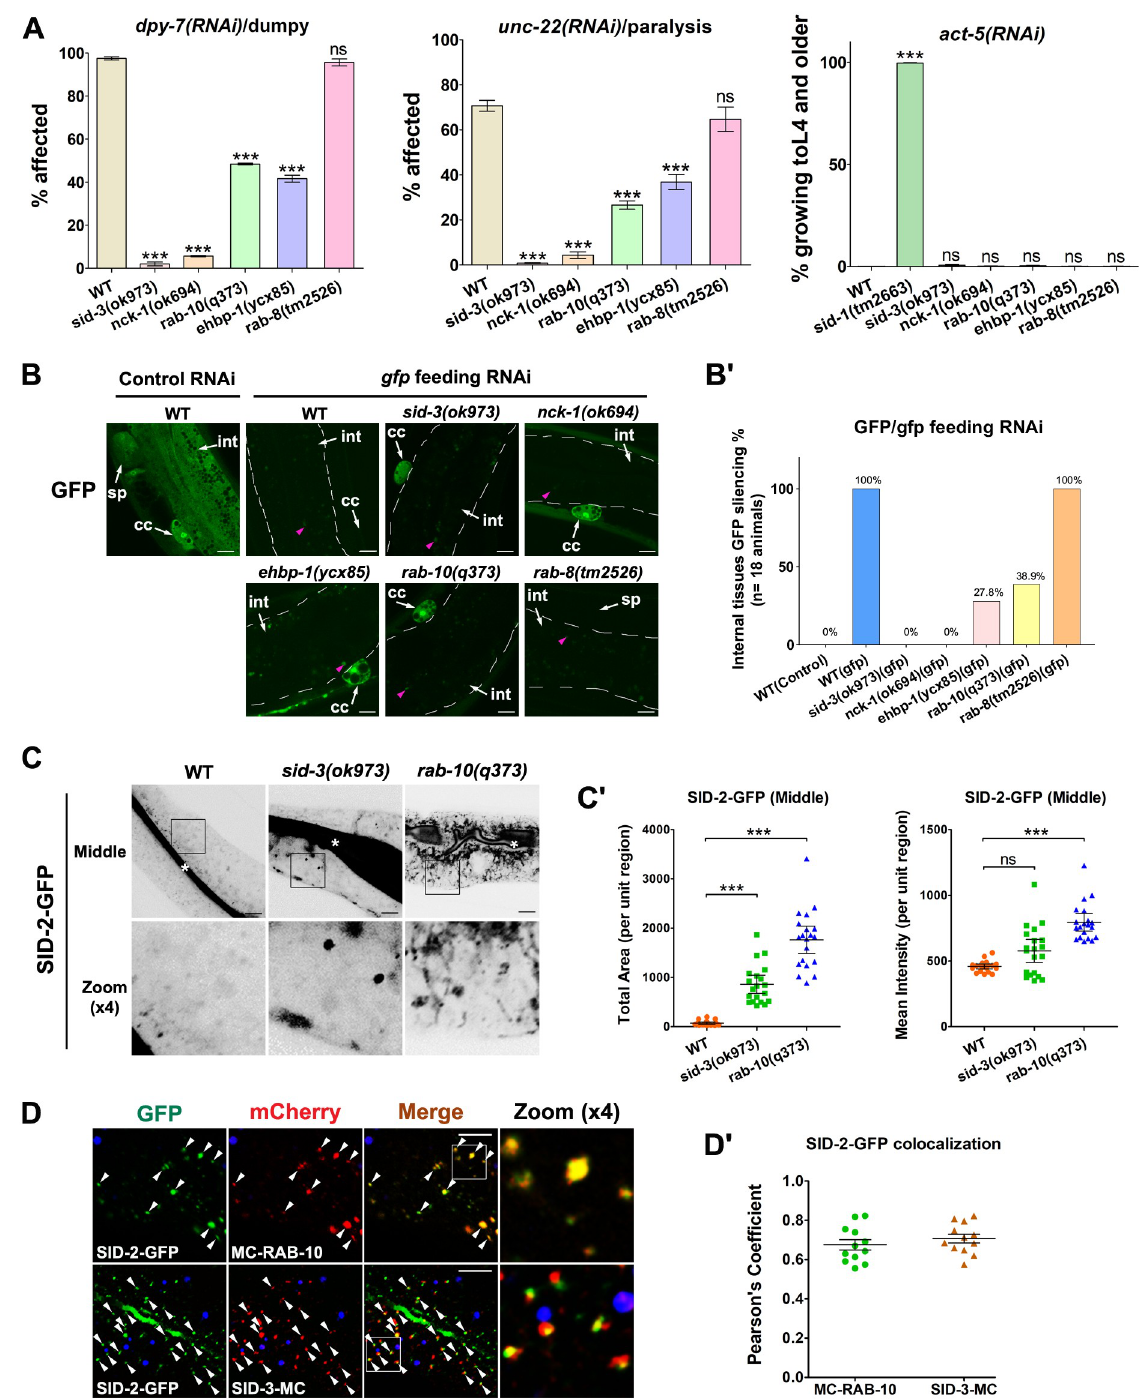
Fig 6. Recycling defect reduces the efficiency of feeding RNAi. ( A ) Feeding RNAi of endogenous genes. Fourth larval stage (L4) animals of wild-type, sid-3(ok973) , nck-1(ok694) , rab-10(q373) , ehbp-1(ycx85) , and rab-8(tm2526) were fed bacteria expressing dsRNA that target skin ( dpy-7 ) and muscle ( unc-22 ). The percentage of affected progeny is shown. For feeding RNAi of act-5 gene, L1 animals were fed bacteria expressing dsRNA that target intestine ( act-5 ). Progeny surviving percentage is shown. Error bars are SEMs, n � 100; asterisks indicate the significant differences in the one-tailed Student’s t-test ( ��� p < 0.001, ns: no significance). ( B-B 0 ) Feeding RNAi of GFP in transgenic animals expressing GFP broadly. Synchronized L1 worms in wild-type, sid-3(ok973) , nck-1(ok694) , ehbp-1(ycx85) , rab-10(q373) , and rab-8(tm2526) genetic backgrounds were fed bacteria expressing gfp -dsRNA. White arrows indicate intestine (int), coelomocyte (cc), and spermatheca (sp).